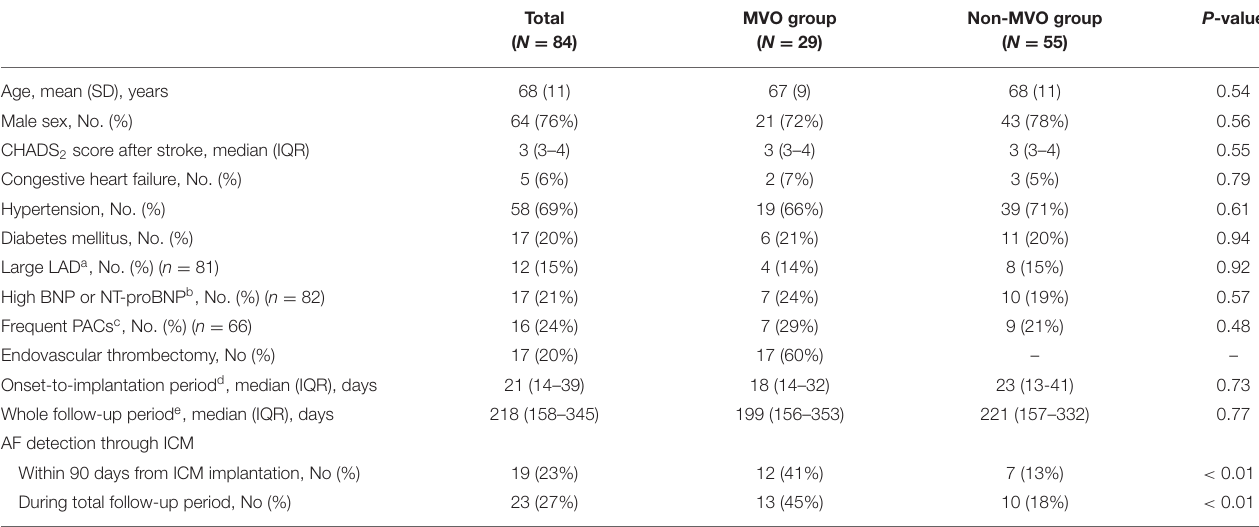
TABLE 1 | Background characteristics and proportion of atrial fibrillation